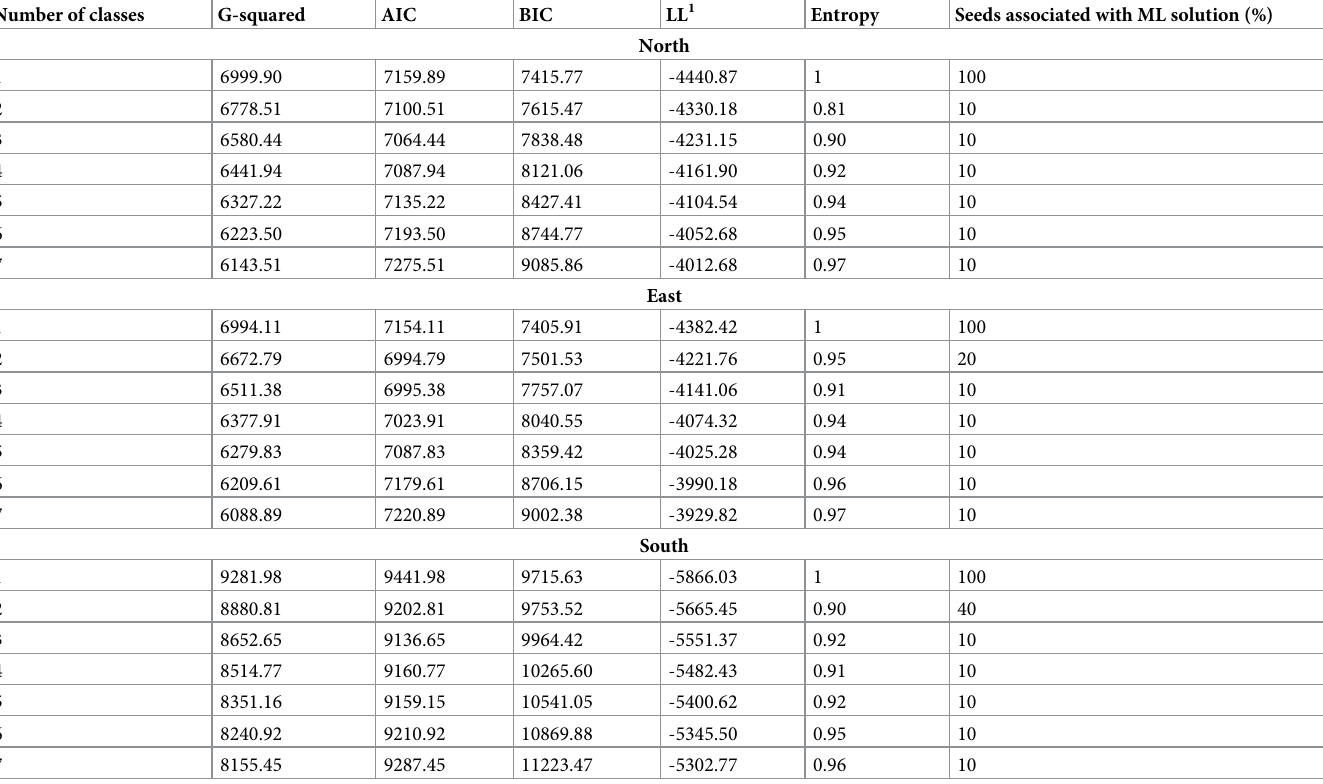
Table 2. Person-centered analysis of personality profiles: Absolute and relative model fit of SAS 1 software PROC LCA baseline model estimation by region. Number of